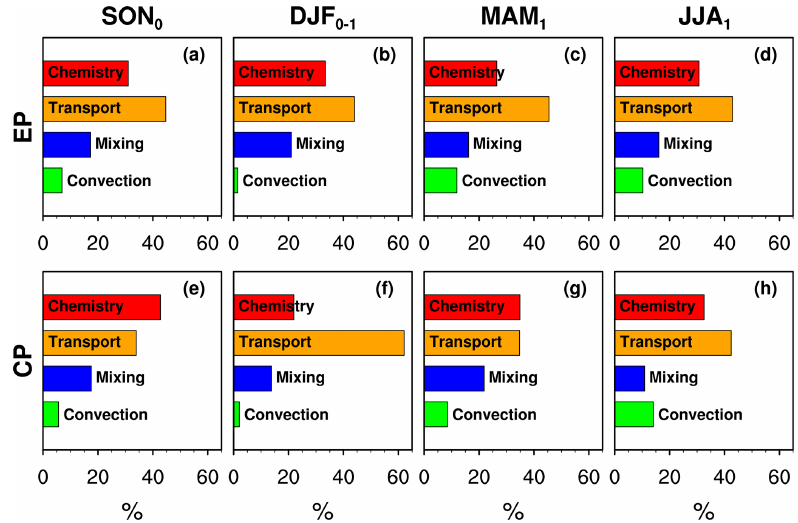
Figure 5. The absolute contribution (in %) of model processes, including chemistry (red), transport (orange), mixing (blue), and convection (green) driven by the composite meteorological fields, for four seasons in EP and CP El Niño years. These are the area-averaged values